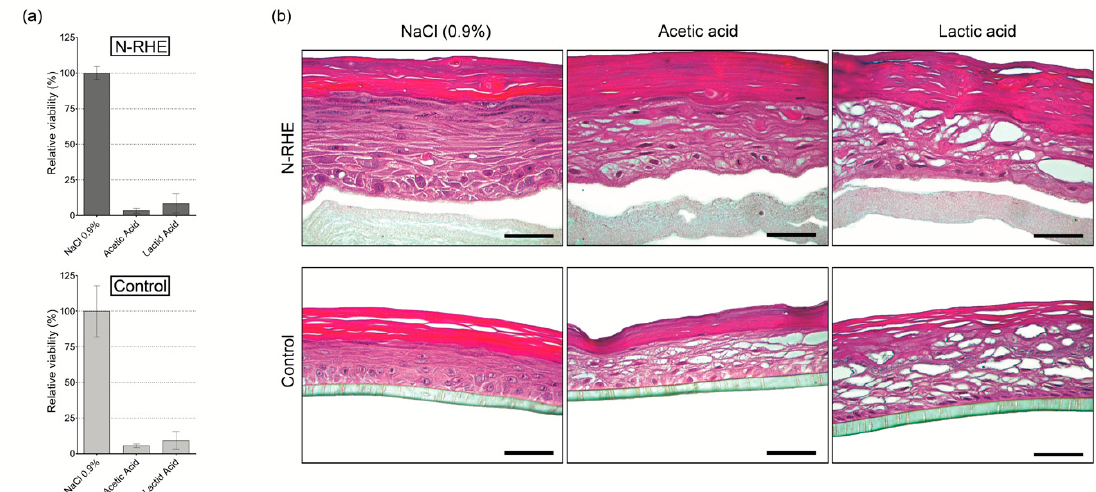
Figure 5. In vitro evaluation of skin corrosion of N-RHE and epidermal control (USP-RHE): ( a ) Viability, according to OECD TG 431. Results are expressed as mean ± standard deviation of two independent experiments (n = 2), each tested with three different tissue replicates; ( b ) Histological analysis of H&E stained vertical paraffin sections. Results were obtained after exposure to substances: NaCl (0.9%), acetic acid, and lactic acid. Bar = 50 μ m.